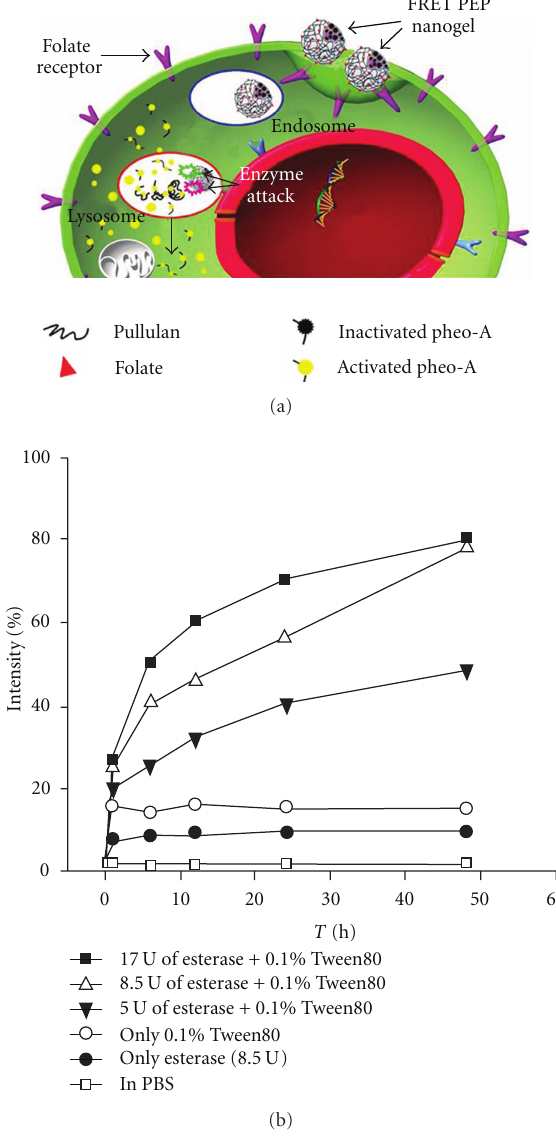
Figure 4: Conceptual image of the changes in photoactivity of polymeric carrier for PSs in cells (a). Enzymatic activation of polymeric carrier for PSs photoactivity. (b) Esterase e ff ect according to time and concentration [12].